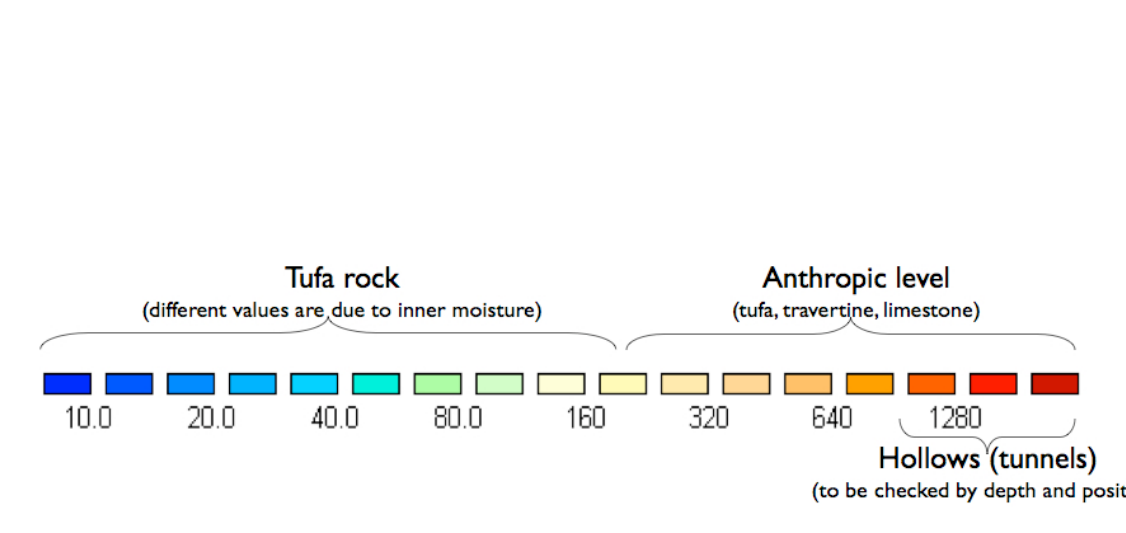
Fig. 7. Our resistivity scale of colors, corresponding to different materials (A. M.